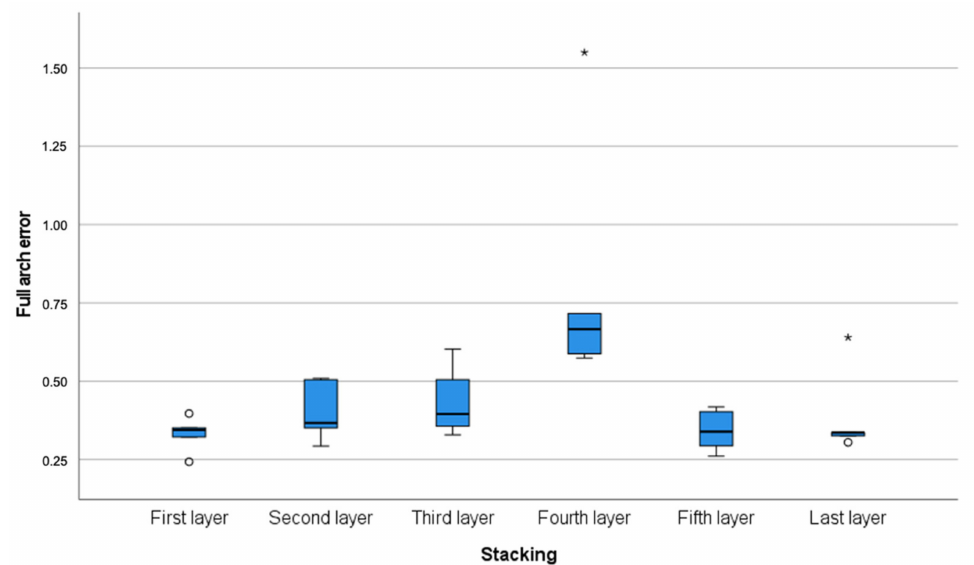
Figure 3. Full-arch error (trueness and precision) calculated through the vectors extended between the centres of the spheres according to stacking layers. Measurements in millimetres. * Denotes outliers. Consistently, significant differences ( p = 0.005) were observed for the left posterior (vectors V 1 , V 2 , V 7 ) arch segment between the fourth model and most of the models; with the fourth model displaying the most shrinkage with a higher median deviation error (136 µ m) and interquartile range of 12 µ m. No differences were observed for the right posterior (vectors V 19 , V 20 , V 21 ) arch segment between the stacked models (Table 2). However, significant differences ( p < 0.001) were seen between the left and right posterior arch segments in relation to the dimensional accuracy of all models, regardless of the batch. The left posterior arch segments were less dimensionally accurate compared to the right posterior arch segments. More shrinkage was detected in the left posterior arch segment compared to the right side with a trueness of − 6 µ m and 29 µ m and precision of 21 µ m and 22 µ m, respectively (Table